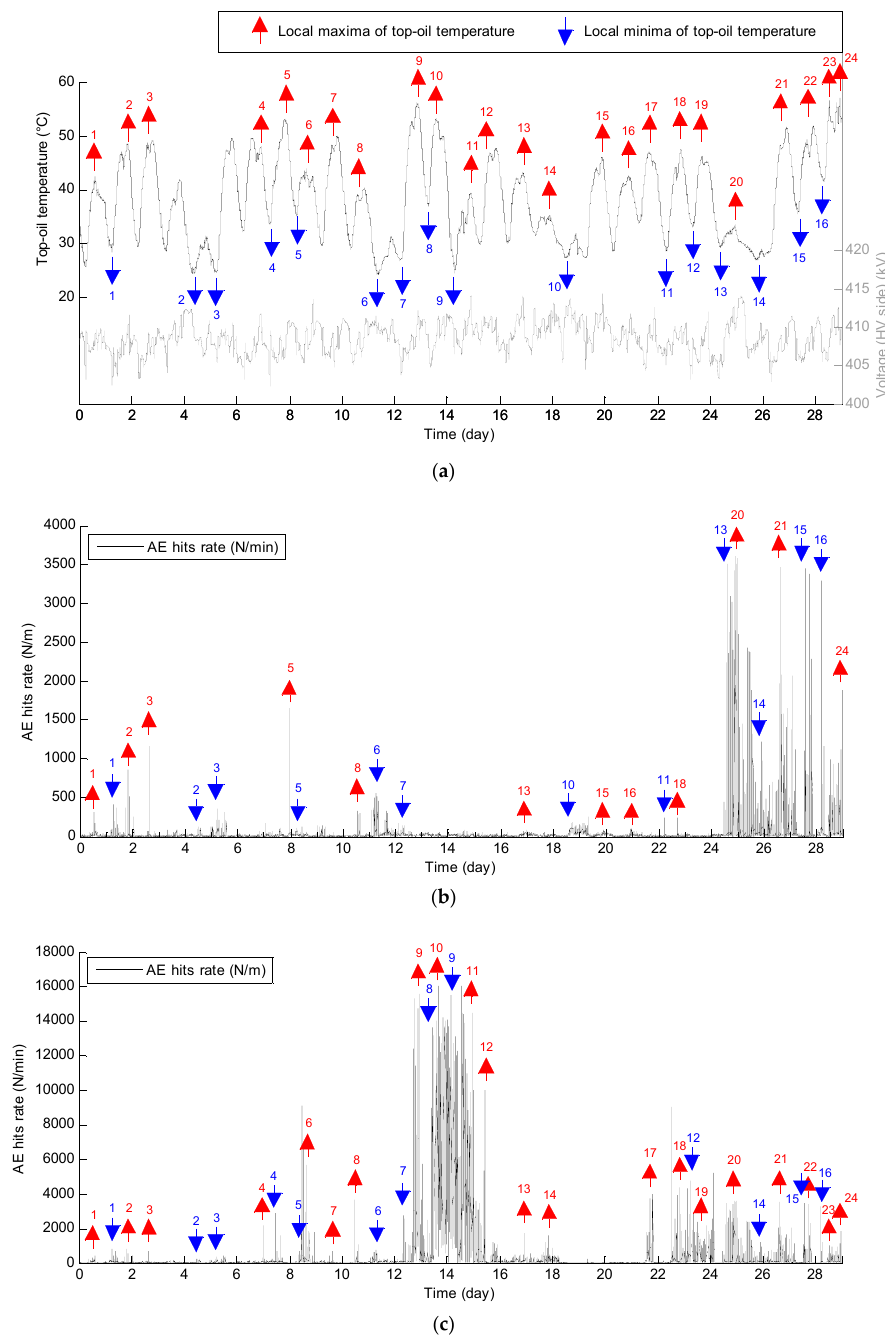
Figure 4. ( a ) Comparison of voltage, top-oil temperature (peaks and troughs are marked by arrows); ( b ) PD activity (AE hits rate per minute) registered in the high voltage HV1 phase; and ( c ) PD activity (AE hits rate per minute) registered in the high voltage HV2 phase during monthly monitoring of a 330 MVA/400 kV/110 kV power transformer.